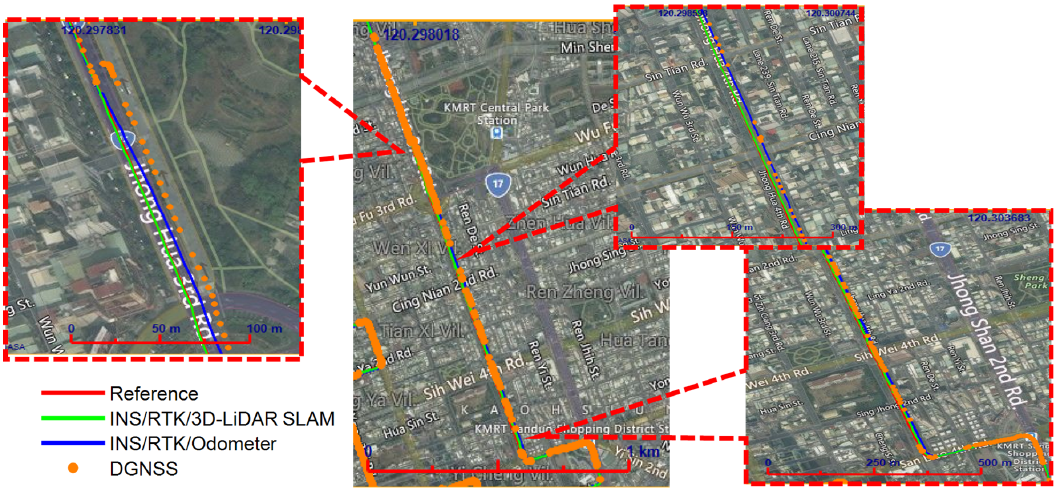
Figure 11. Scenario 1: zoomed GNSS-hostile area with severe multipath interference or non-line-of-sight (NLOS) reception. Remote Sens. 2020 , 12 , x FOR PEER REVIEW